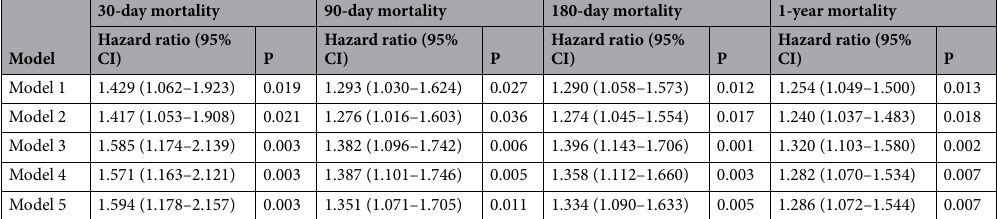
Table 2. Association between MHR group and the outcomes of patients after cardiac surgery. Hazard ratio and 95% CI for MHR group in 30-day, 90-day, 180-day and 1-year mortality were calculated using different Cox regression models. Model 1, univariate Cox regression analysis of MHR with mortality; Model 2 adjusted for model 1 plus gender, age, ethnicity; Model 3 adjusted for model 2 plus SBP, DBP,SOFA; Model 4 adjusted for model 3 plus hypertension, CKD, COPD, diabetes; Model 5 adjusted for model 4 plus beta blocker, milrinone, dobutamine, dopamine, norepinephrine.